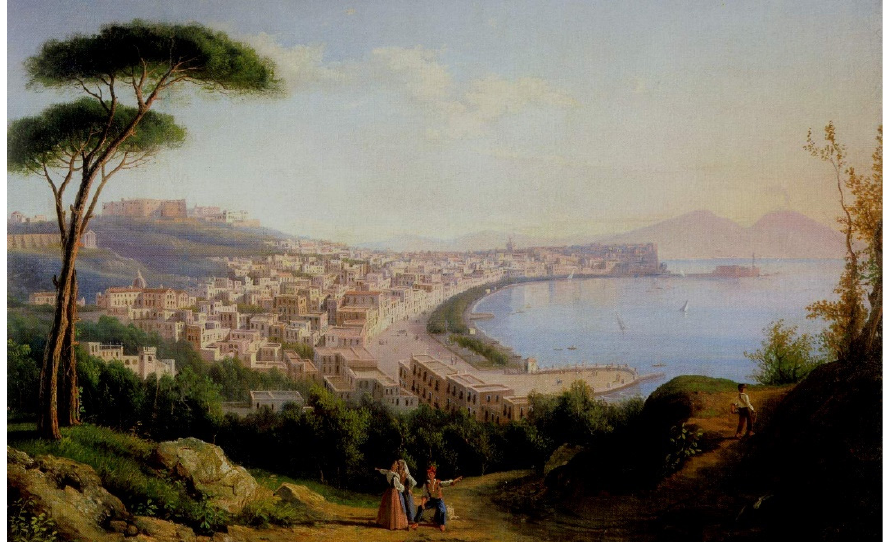
Figure 29. Sylvester Shchedrin. A View of Naples from the Road to Posillipo , 1829. Pozhalostin Ryazan State Regional Museum of Art.